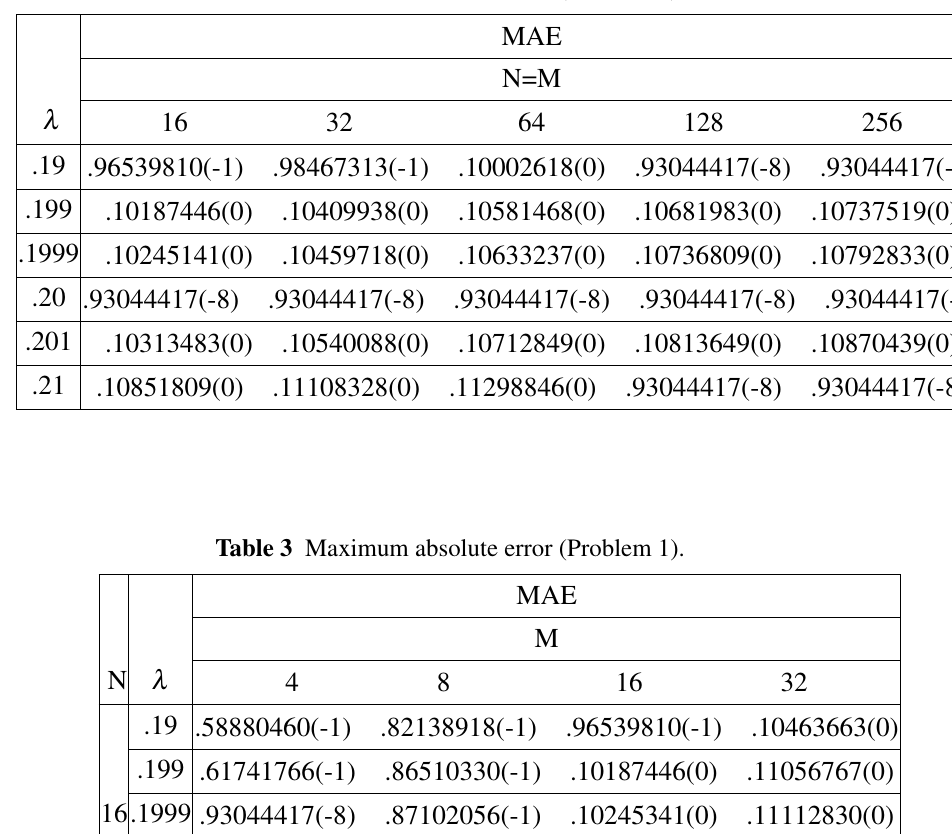
Table 2 Maximum absolute error (Problem 1).